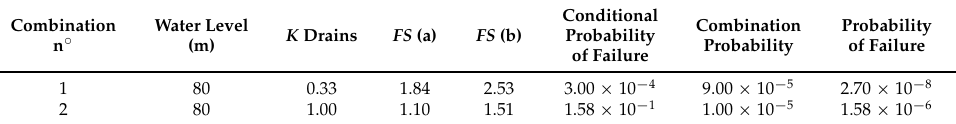
Table 8. Approach II. Results for n = 5.